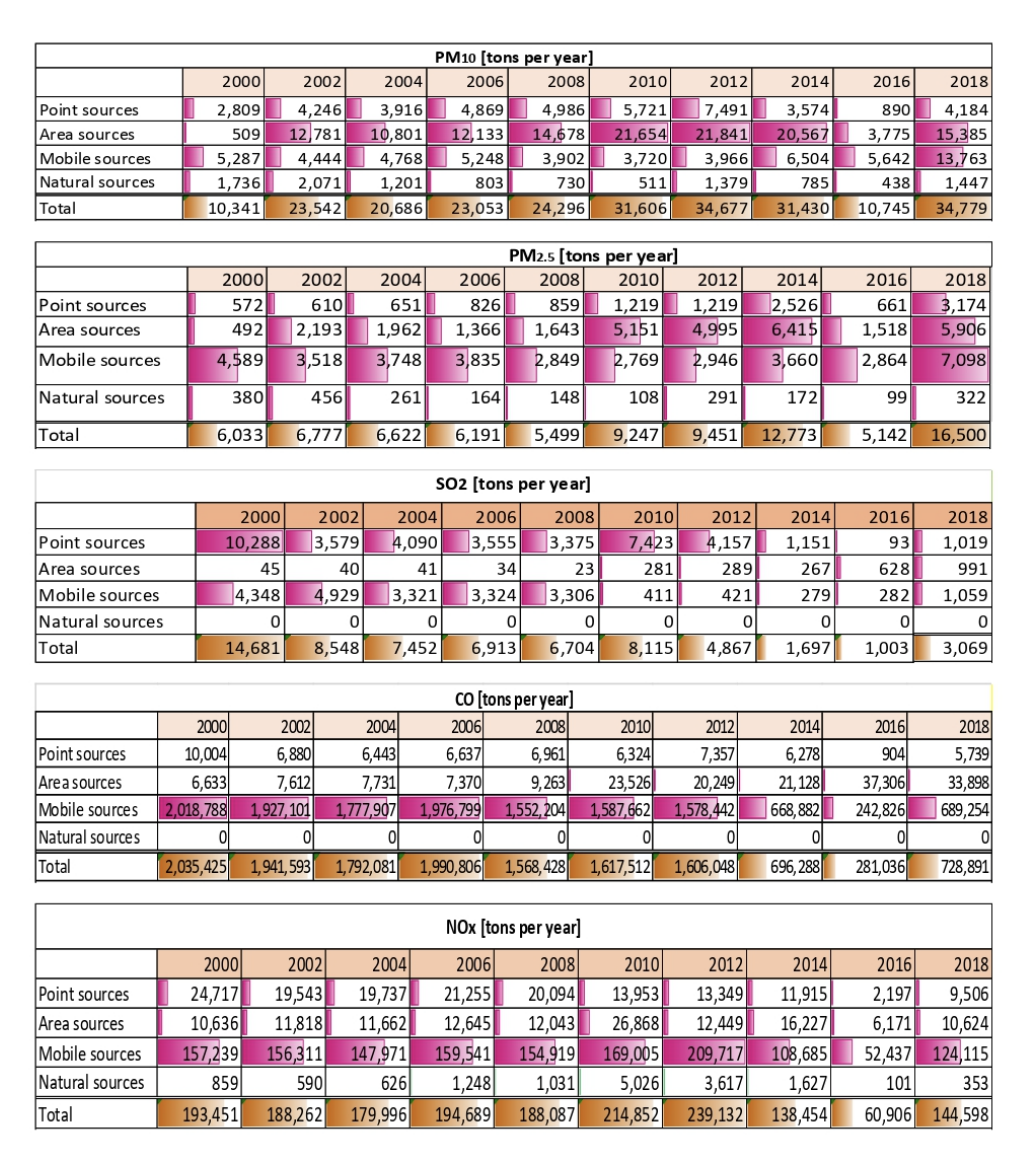
Figure 1. Annual emissions (2000–2018) (tons per year) of the